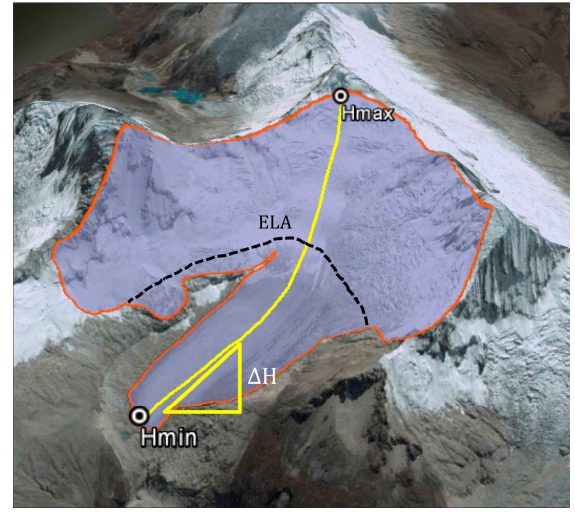
Figure 9. Estimation of glacier response time at Glaciar Artesonraju; H max , H min = maximum, minimum elevation, ∆ H = elevation range (H max − H min ), ELA = estimated equilibrium line altitude.